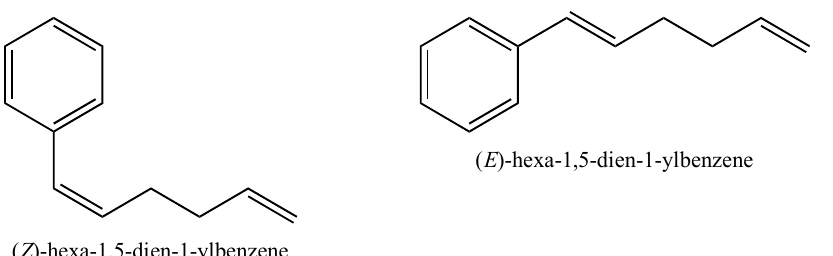
Figure 22. Possible product structures for the coupling reaction between phenylboronic acid and 1,5-cyclooctadiene.